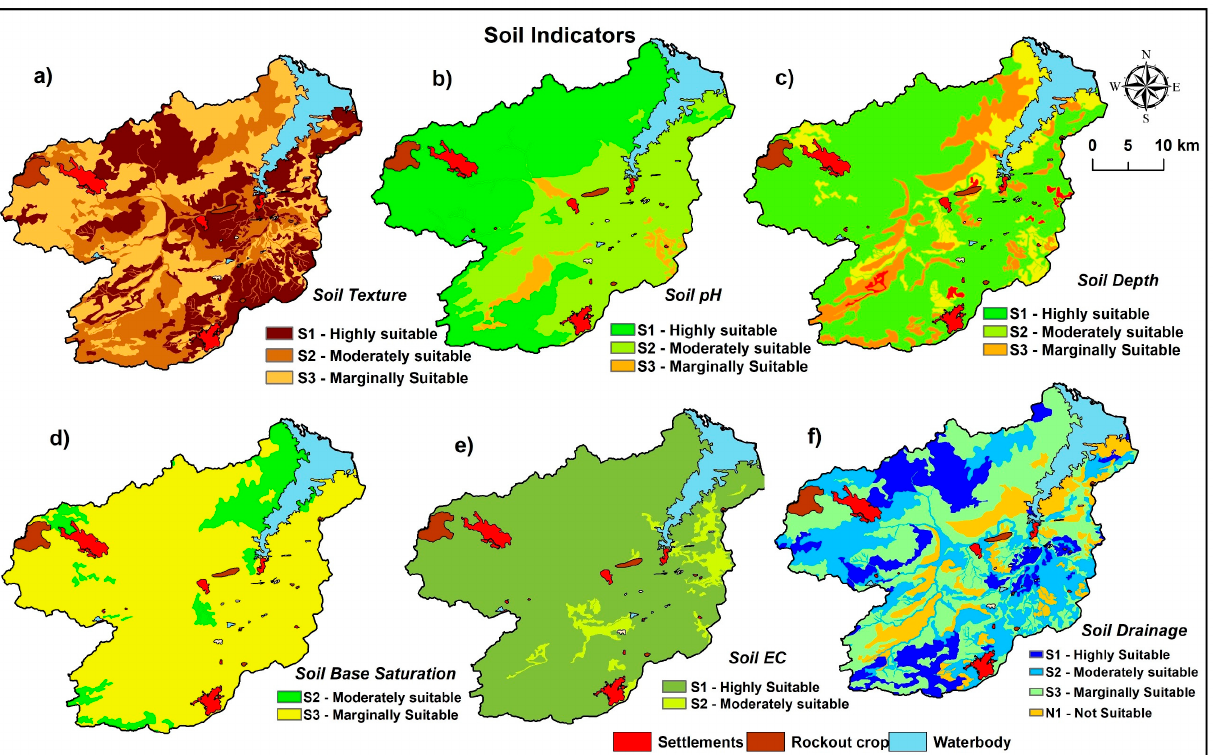
Figure 4. Suitability classes of soil indicators: ( a ) soil texture, ( b ) soil pH, ( c ) soil depth, ( d ) base saturation, ( e ) soil EC, and ( f ) soil drainage.